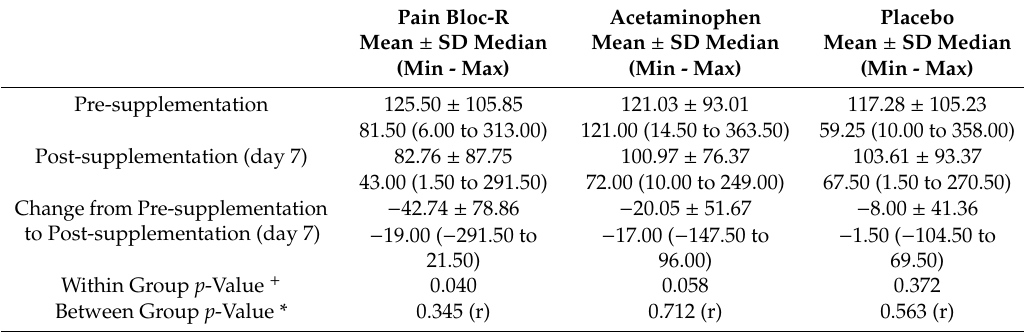
Table 6. The modified Cornell musculoskeletal discomfort (MD) total score and change in MD score from pre-supplementation to day 7 in the PP population ( n =